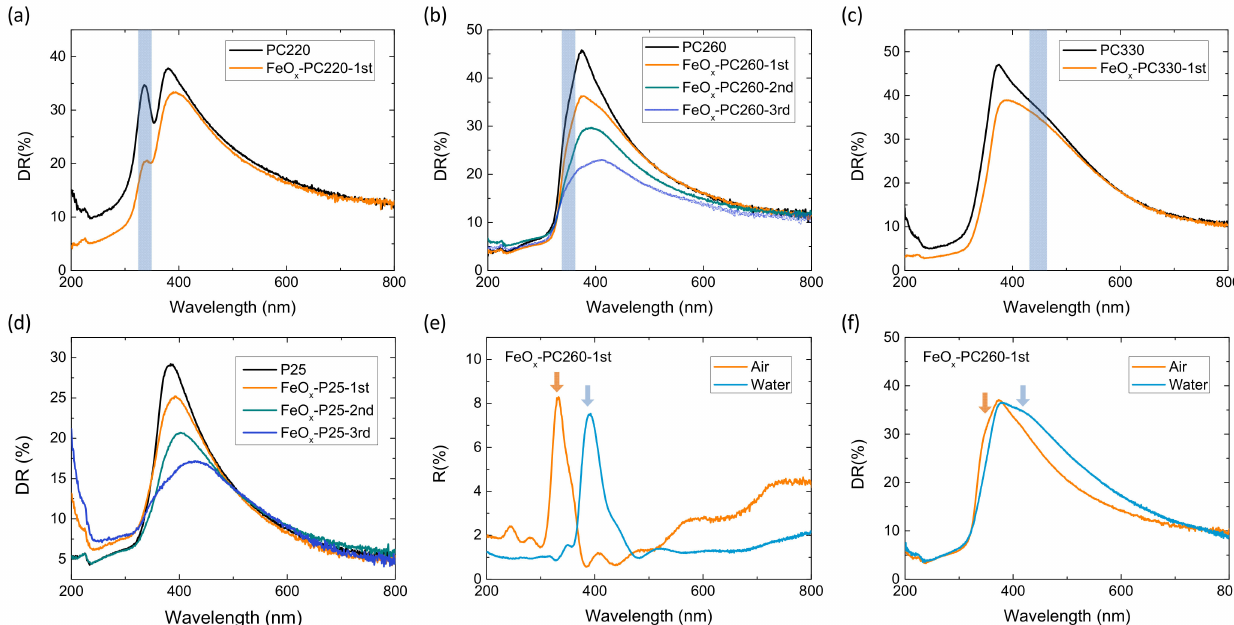
Figure 4. Diffuse reflectance spectra for the ( a ) PC220, ( b ) PC260, ( c ) PC330, and ( d ) P25 films before and after FeO x CCC modification. Shaded bands denote the positions of the DR% Bragg reflectance for the PC films. Comparative ( e ) diffuse and ( f ) specular reflectance spectra for FeO x –PC260-1st films in air and water.